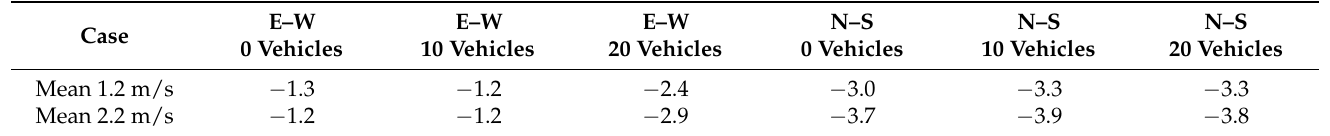
Table 5. Average reduction of temperature according to the mean wind speed for each orientation. Values in ◦ C.